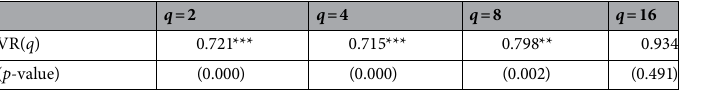
H 0 ∶ The data follow a normal